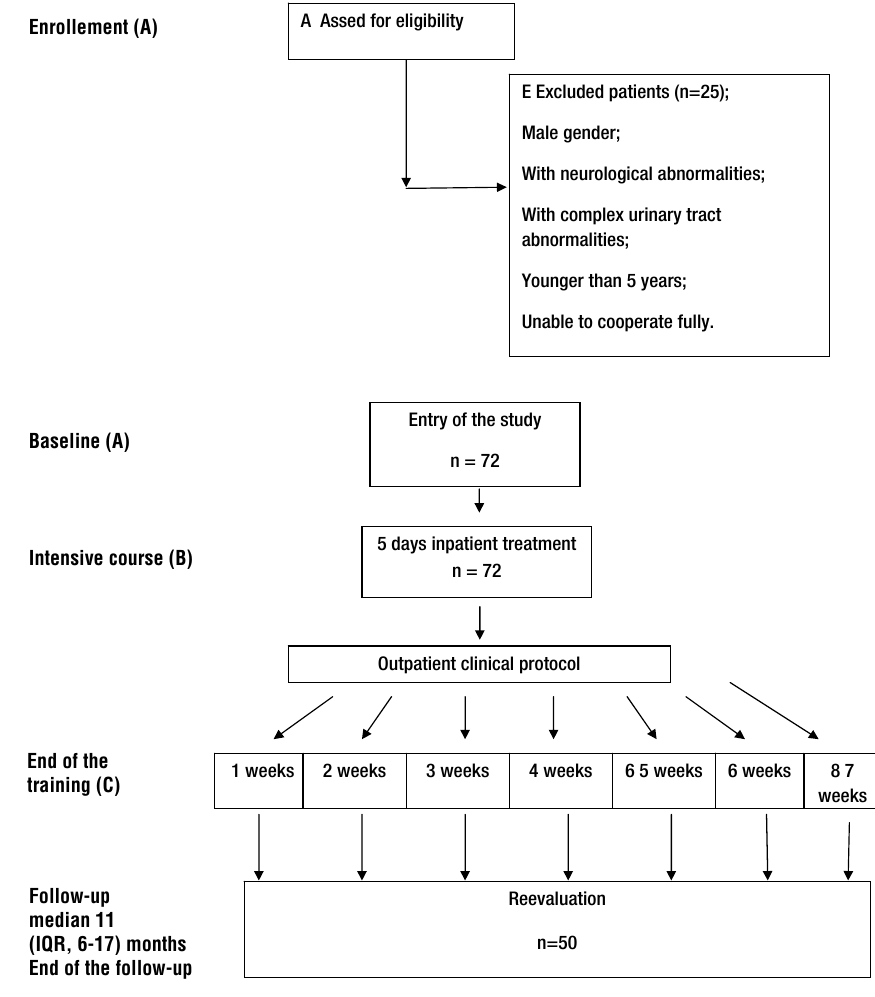
Figure 1 - Flow chart describing the progress of the patients through the trial.